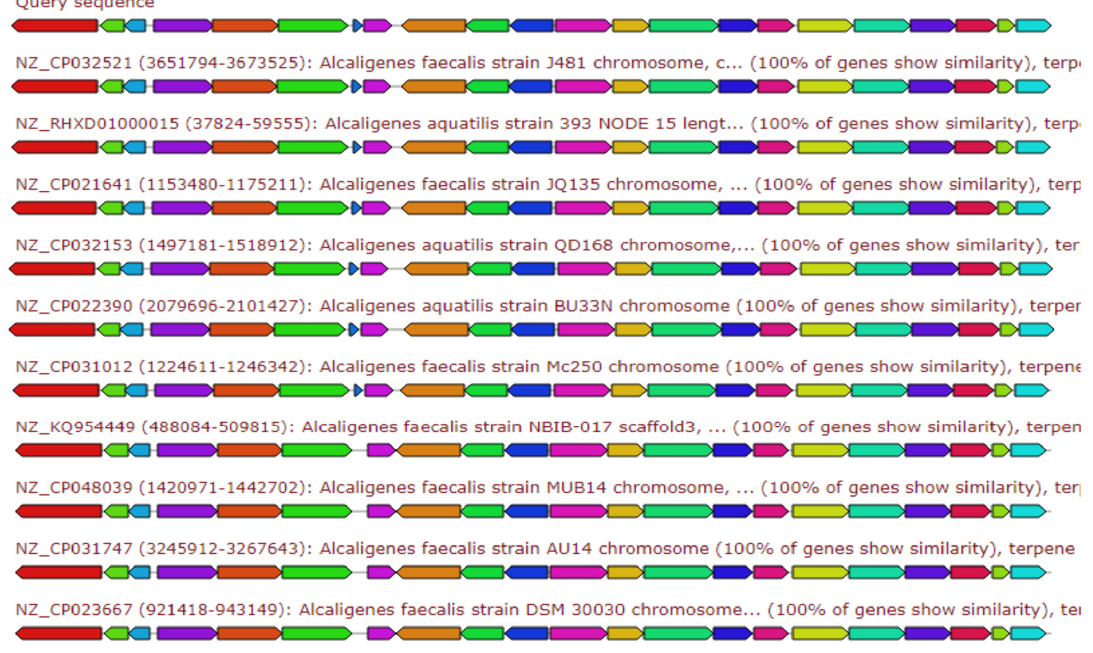
Figure 7. Gene arrangement of the top 10 Alcaligenes sp. showing homologous to query sequence of A. faecalis isolate MZ921504 for Terpene biosynthetic gene cluster. Putative biosynthetic genes presented in red, additional biosynthetic genes in orange, transport-related genes in blue, regulation-related genes in green color, resistance genes in pink, TTA codon in dark pink and grey represent other genes.